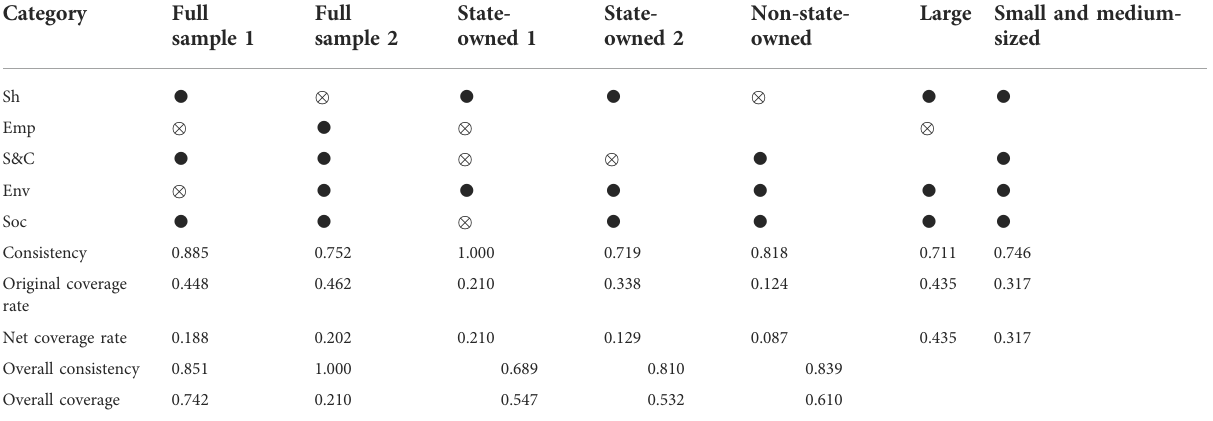
TABLE 4 Path Con fi gurations of high green value performance under different conditions.